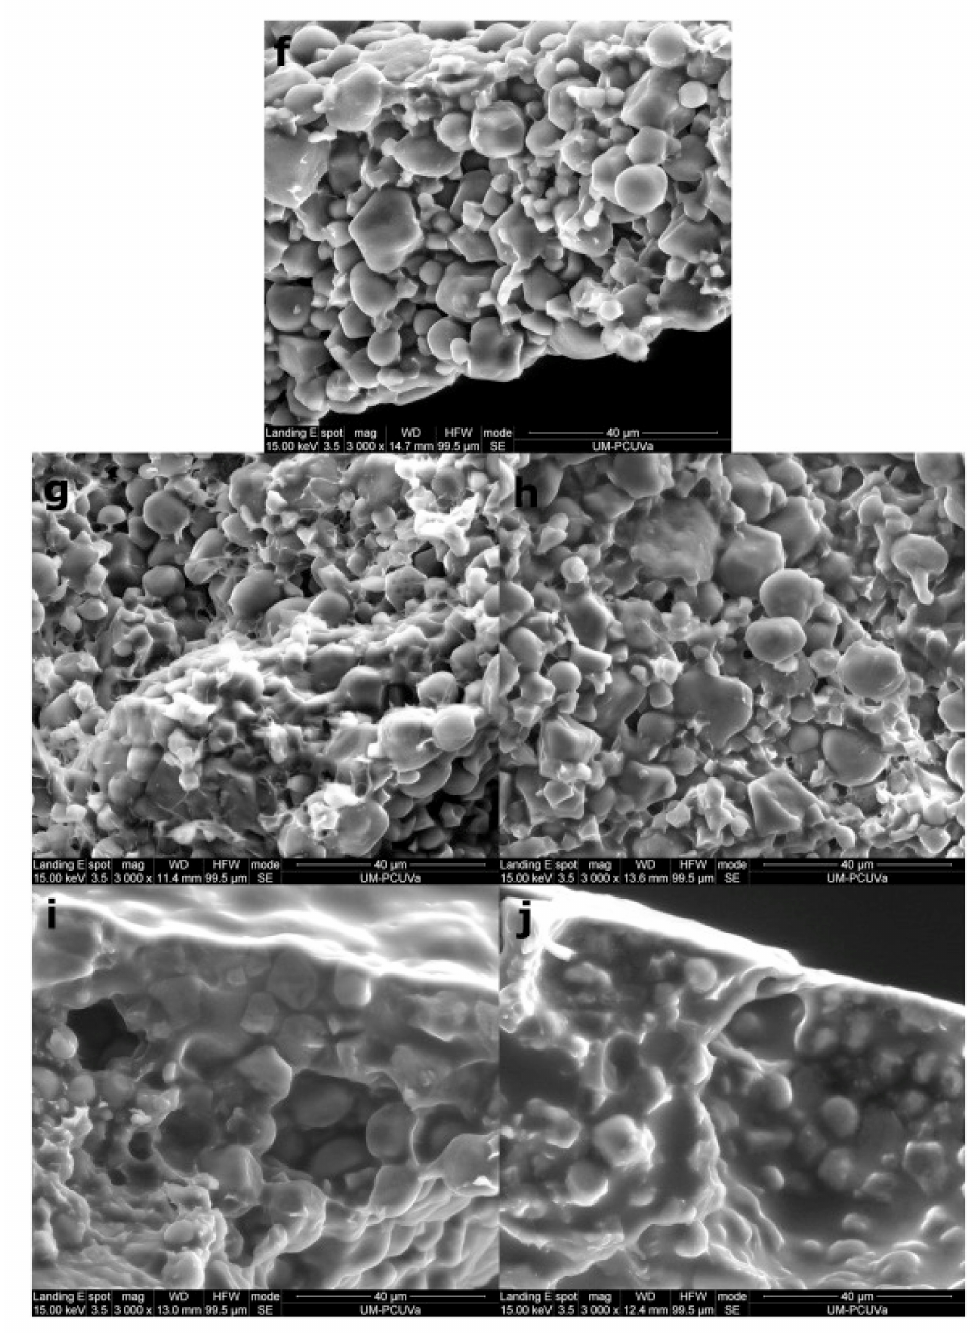
Figure 1. Micrographs of crust cross-section at 3000 × magnification. Images correspond to breads supplemented with 10% protein and control sample: Control (50% rice flour: 50% maize starch) ( f ), Rice protein 10% ( g ), Pea protein 10% ( h ), Egg white powder 10% ( i ), Whey protein 10% ( j )